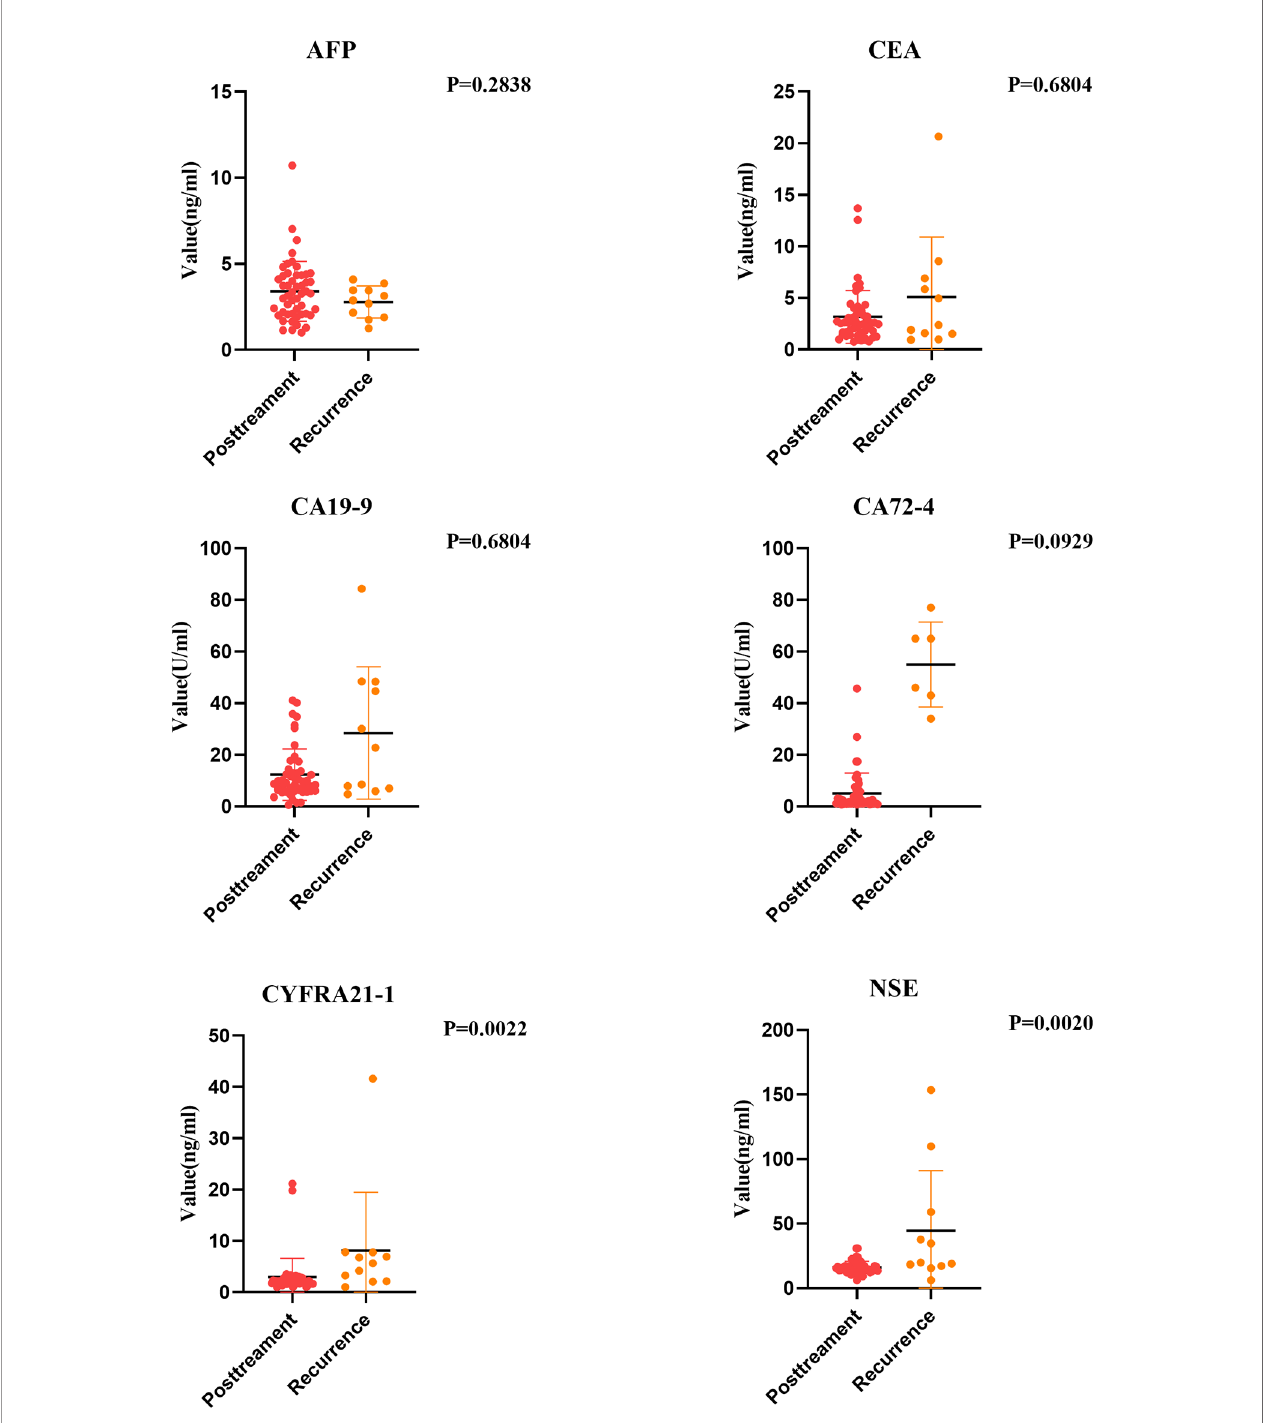
FIGURE 6 | Comparison of Tumor Markers between Pretreatment and Recurrence